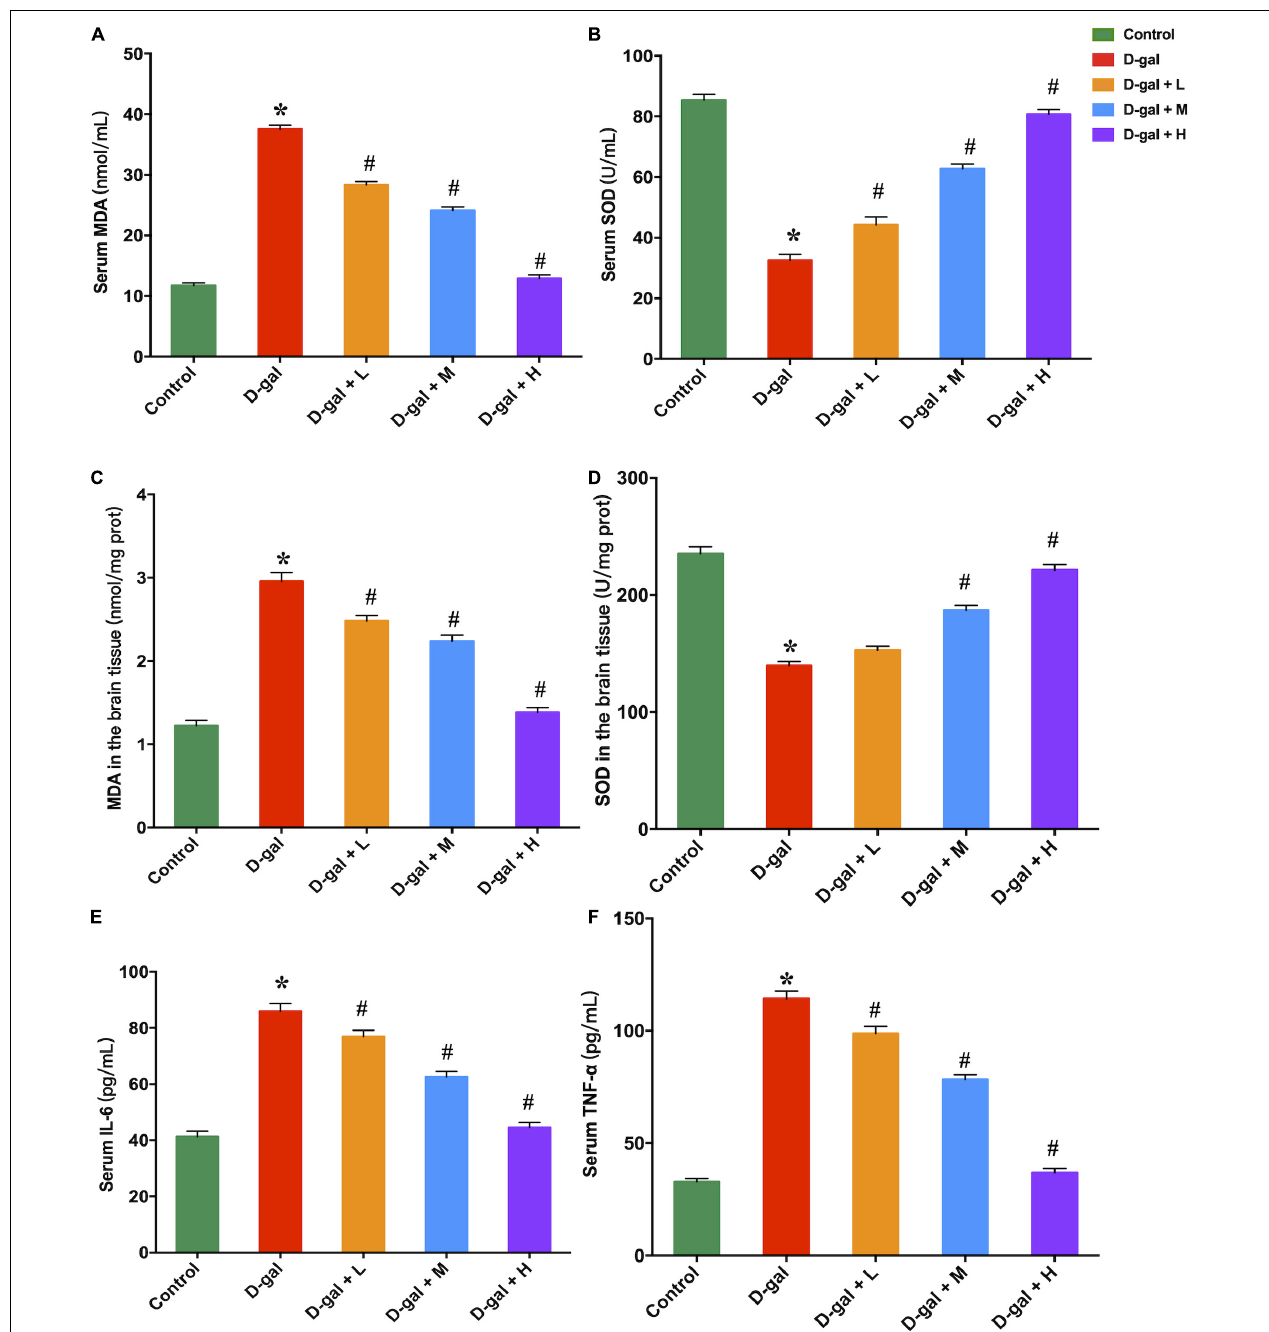
FIGURE 5 | Effects of the dietary supplement on MDA (A,C) and SOD (B,D) contents in both serum and brain tissues, and serum IL-6 (E) and TNF- α (F) concentrations ( n = 8 in each group). Values are presented as means ± SEM. * p < 0.05 when compared with the control group; # p < 0.05 when compared with the D-gal group. IL-6, interleukin-6; MDA, malondialdehyde; SEM, standard error of mean; SOD, superoxidase dismutase; TNF- α , tumor necrosis factor- α .